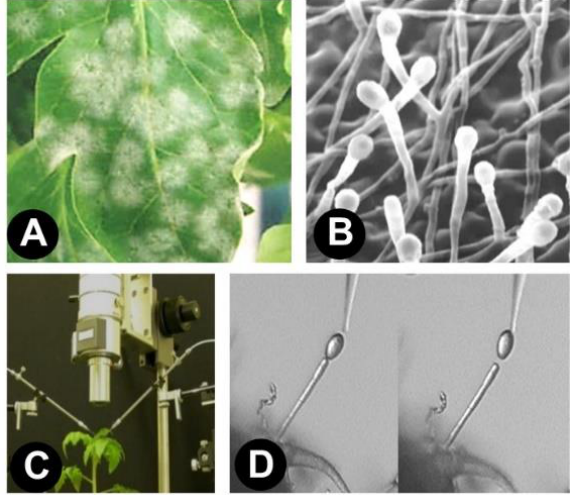
Figure 1. ( A ) Fungal colonies on tomato leaves; ( B ) electron micrograph of conidiophores within a colony; ( C ) a high-fidelity digital microscope equipped with two micromanipulators; and ( D ) tomato powdery mildew spore collected with a glass needle held under a high-fidelity digital microscope.